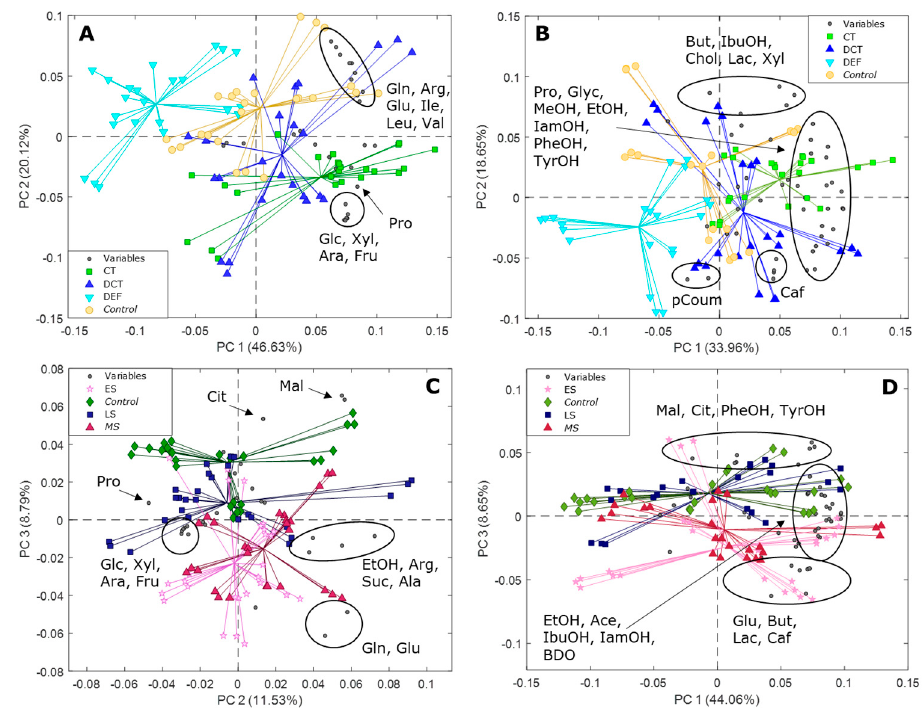
Figure 5. ( A – D ) Biplots of the PCA performed on the metabolite concentrations in must and wine samples from the field experiment (( A , B ), respectively) and must and wine samples from the screen- house experiment (( C , D ), respectively). Legend: CT = crop thinning; DCT = defoliation and crop